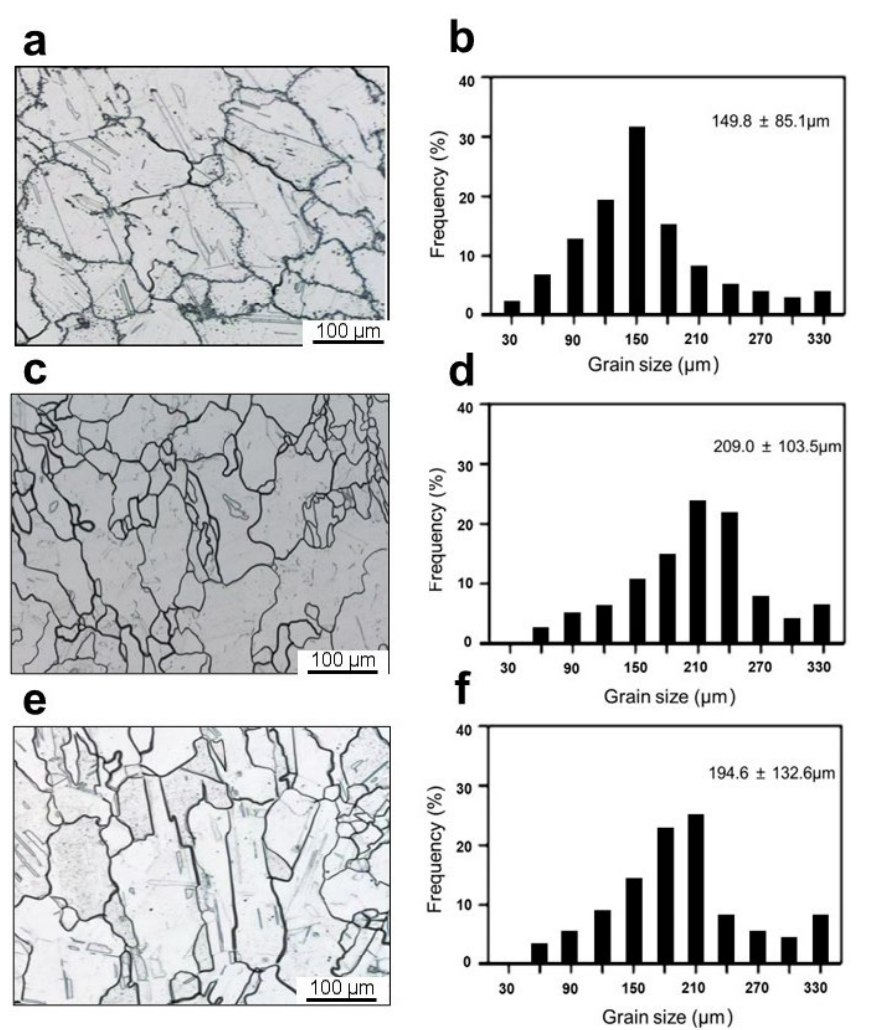
Figure 3. Representative optical microscopy images of ( a ) 1175-FC sample, ( c ) 1175-AC sample, and ( e ) 1175-WQ sample. The equiaxed grain boundaries in ( a , c , e ) are traced by black-color lines. The histograms of equiaxed grains size are shown in ( b , d , f ).